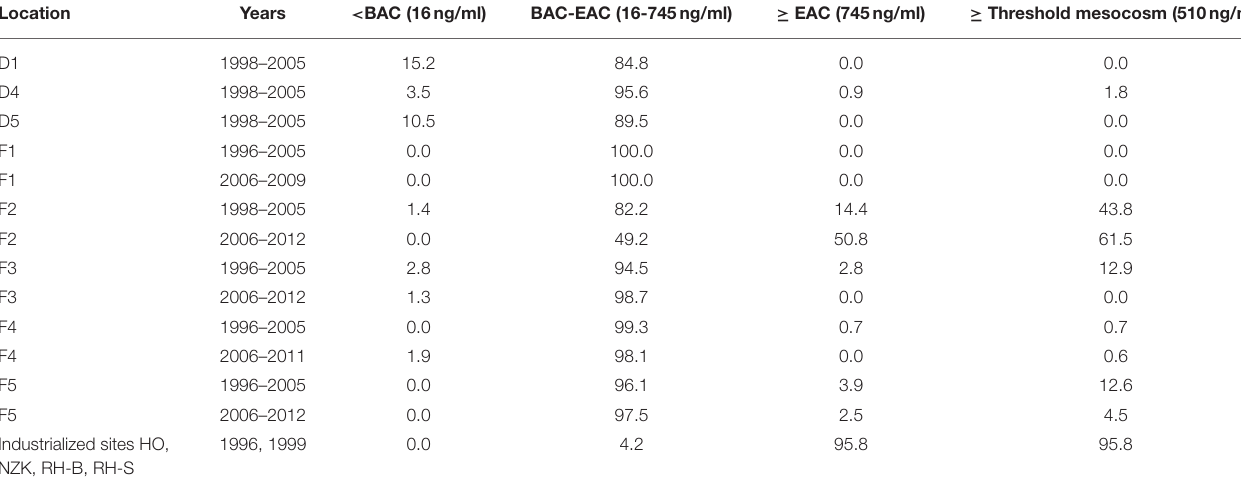
TABLE 2 | Percentages of samples at the dab and flounder locations showing concentrations of 1-OH pyrene below/above Background Assessment Concentration; BAC (16 ng/ml for dab and flounder), Environmental Assessment Concentrations (EAC) for halibut (745 ng/ml) (Hylland et al., 2012) and PAH threshold levels derived from a mesocosm study (Vethaak et al.,